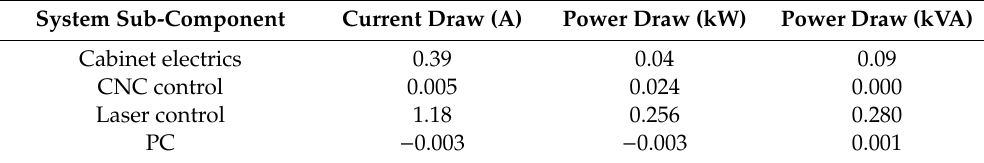
Table 9. Power draws for active but idle